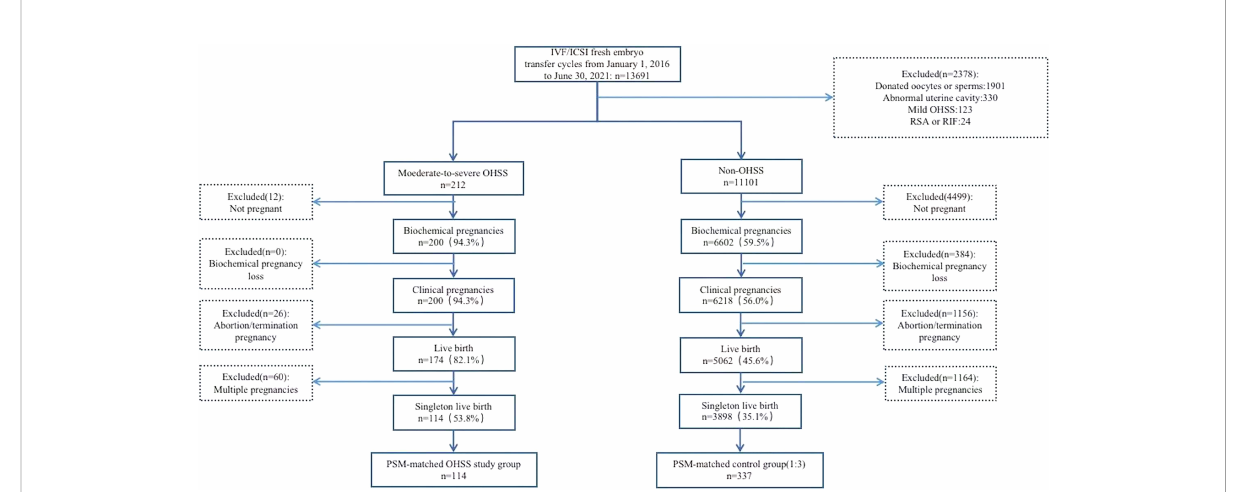
FIGURE 1 Flow diagram of study participants IVF, in vitro fertilization; ICSI, intracytoplasmic sperm injection; OHSS, ovarian hyperstimulation syndrome; RSA, recurrent spontaneous abortion; RIF, repeated implantation failure; PSM, prospensity score matching